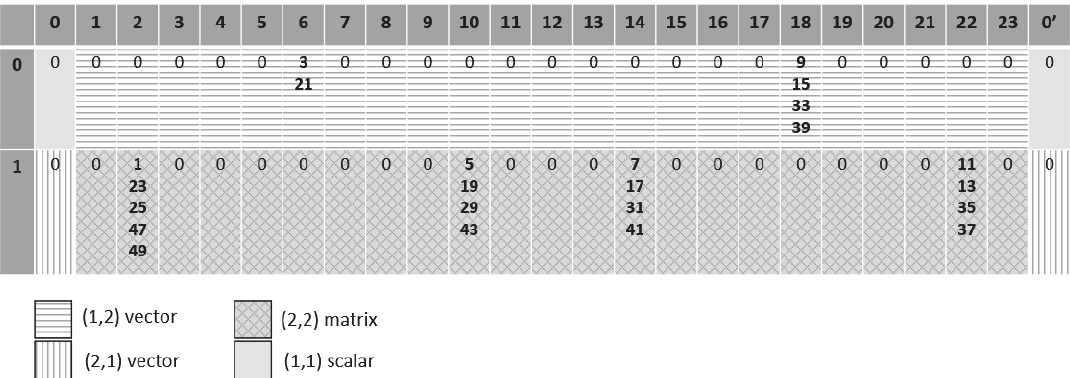
Figure 4. Space harmonics distribution in L sr (cid:4666)θ(cid:4667) for the three ‐ phase IM with 48 bars (in line 1, 4 αβ planes among 23 are excited, each one by several harmonics which lead to important interactions).